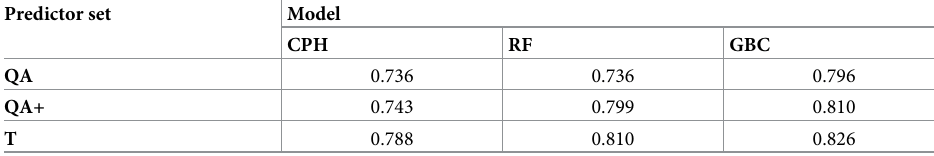
Table 4. Externally validated model discrimination for different predictor sets and modelling techniques: Valida- tion cohort. Predictor set